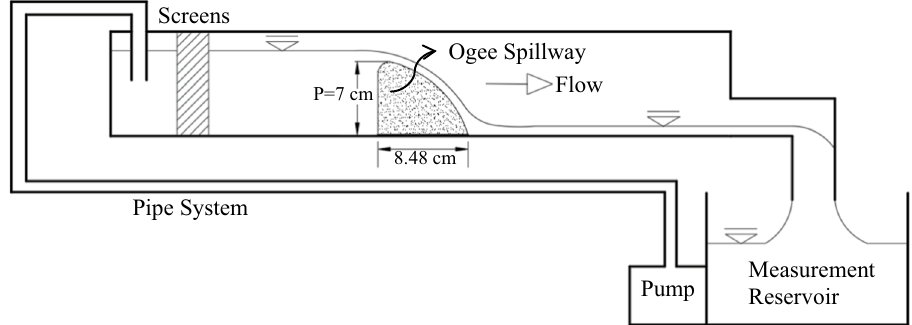
Fig. 4 General scheme of experimental